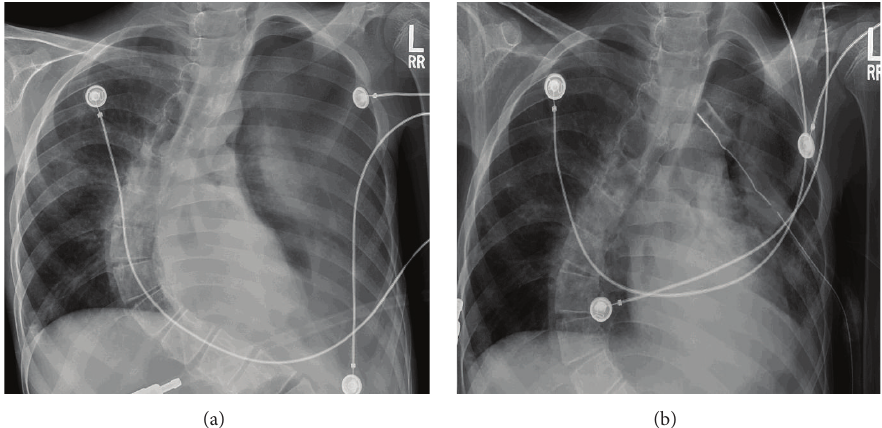
Figure 1: CXR showing (a) left side pneumothorax and pleural effusion. (b) Expansion of the left lung, chest tube, and left sided effusion.